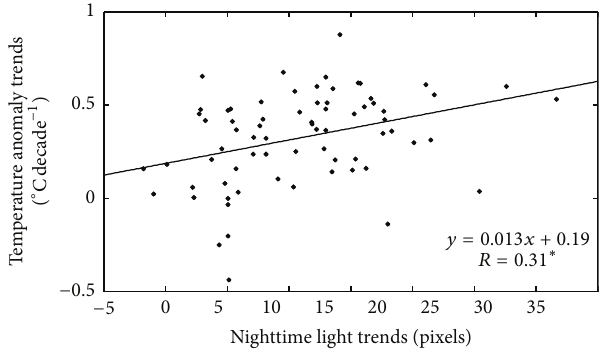
Figure 5: Correlation between the trends of the annual mean SAT and the intensity of the nighttime lights from 1992 to